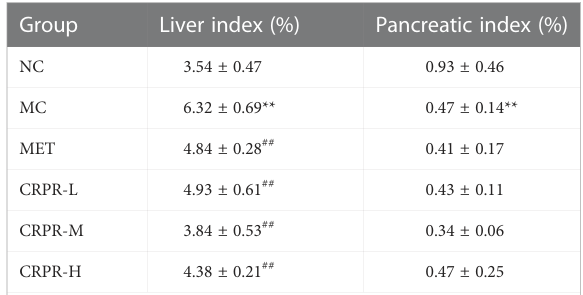
TABLE 4 Effect of CRPR on the liver and pancreatic indices of T2DM